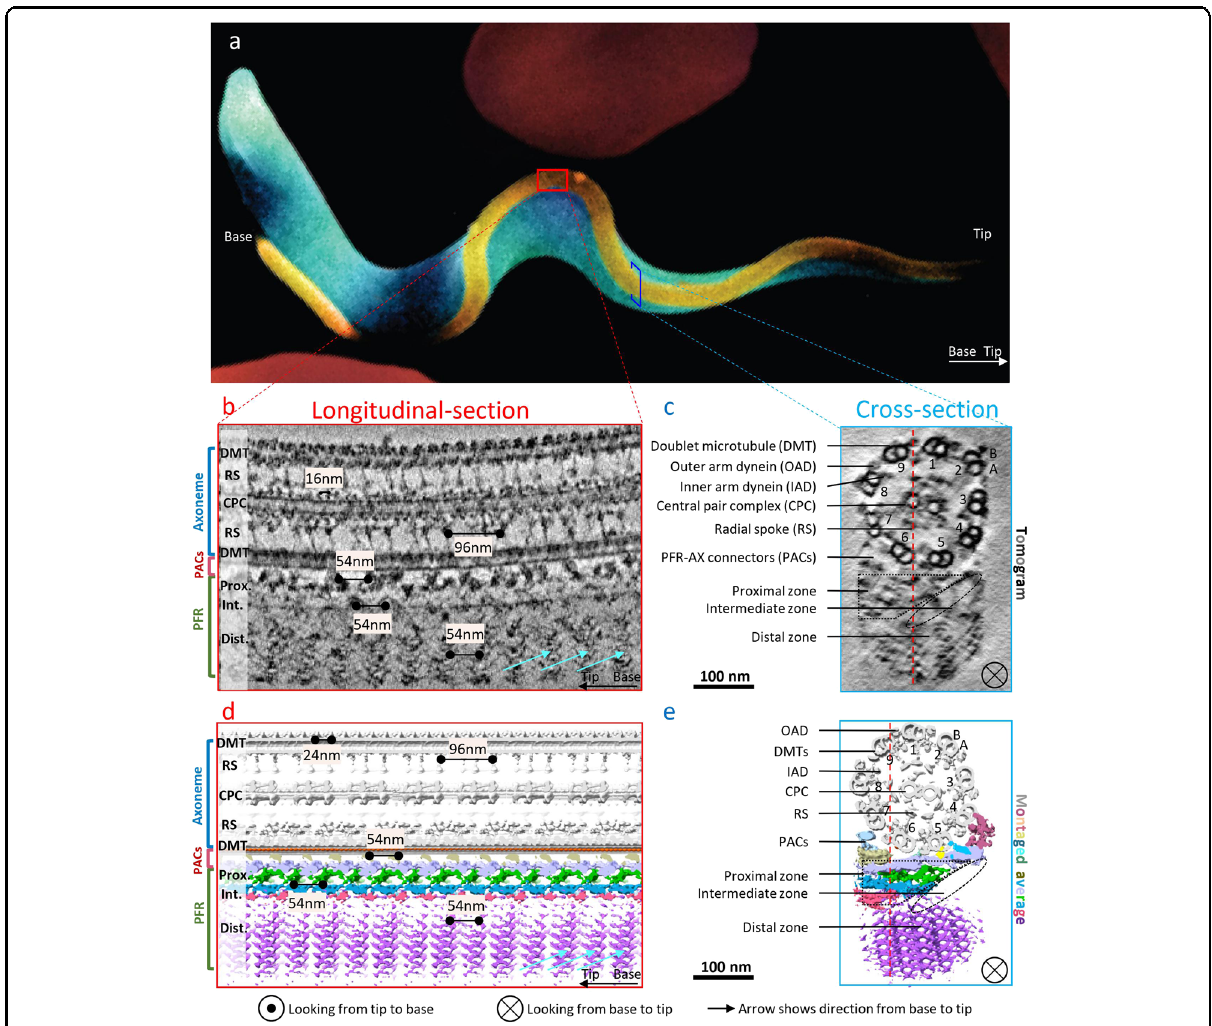
Fig. 1 CryoET of T. brucei fl agellum in its bloodstream form. a A scanning EM image of a trypanosome cell (blue) with fl agellum (gold) adjacent to red blood cells (red). Artistic rendering based on ref. 102 . b , c Longitudinal ( b ) and cross ( c ) sections density slices (10 nm thickness) of a tomogram of the T. brucei axoneme and PFR. Arrows in b point to apparent “ comb teeth ” features in the PFR distal zone. d , e Shaded surface views of longitudinal ( d ) and cross ( e ) sections of a 1248 nm portion of the T. brucei axoneme and PFR, obtained by montaging sub-tomographic averages of the axoneme (96 nm repeat), PACs, PFR proximal and distal zones (54 nm repeat). Symbols indicating orientation are de fi ned at the bottom and are used throughout the fi